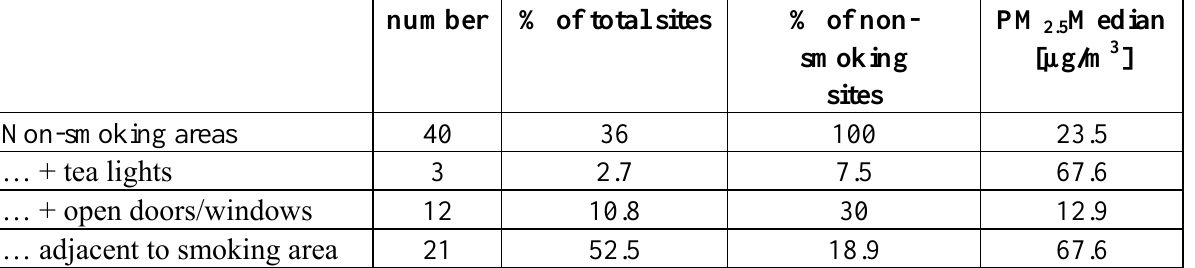
Table 1. Median PM concentrations in non-smoking areas and 2.5